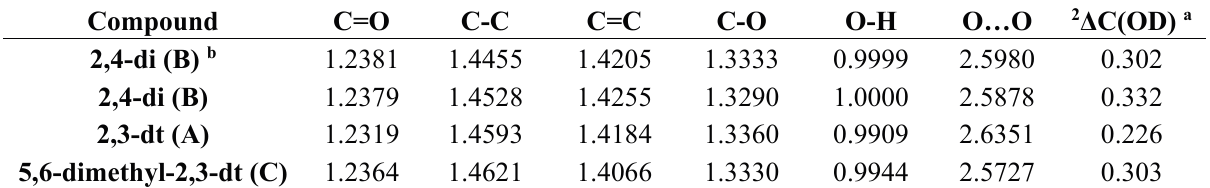
Table 2. Distances around the hydrogen bond in Å for dihydroxyterephthalaldehydes. Compound